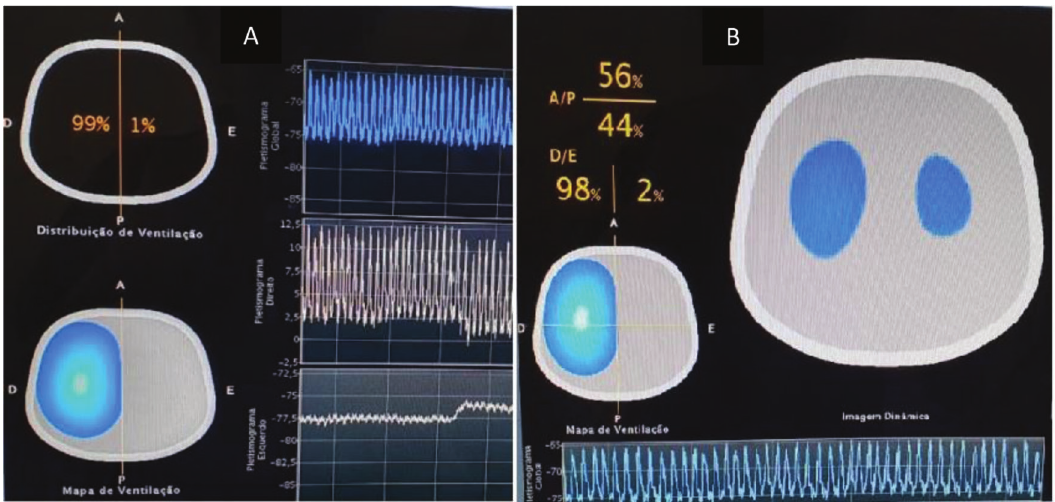
Figure 1 - A. Ventilation distribution in the right (R) and left (L) half thorax. The white image represents the area with an increased aeration distribution, and the blue image shows decreasing aeration distribution. Graphics represent plethysmogram of tidal volume per region: global (superior), right (middle), and left (inferior). B. Ventilation distribution over cross sections: Anterior/Posterior and R/L (images obtained from screen